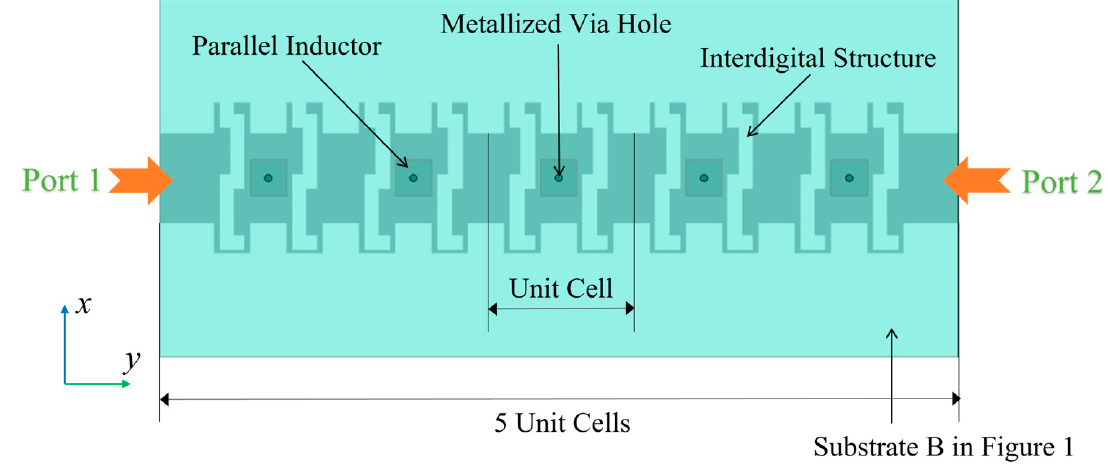
Figure 6. Schematic diagram of the CRLH metamaterial antenna based on LC.